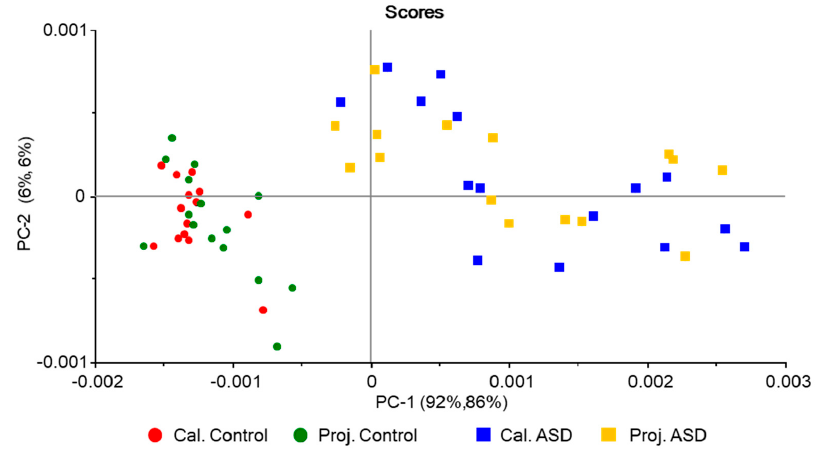
Figure 6. Projection scores plot (PC2 vs. PC-1) for the PCAModel.